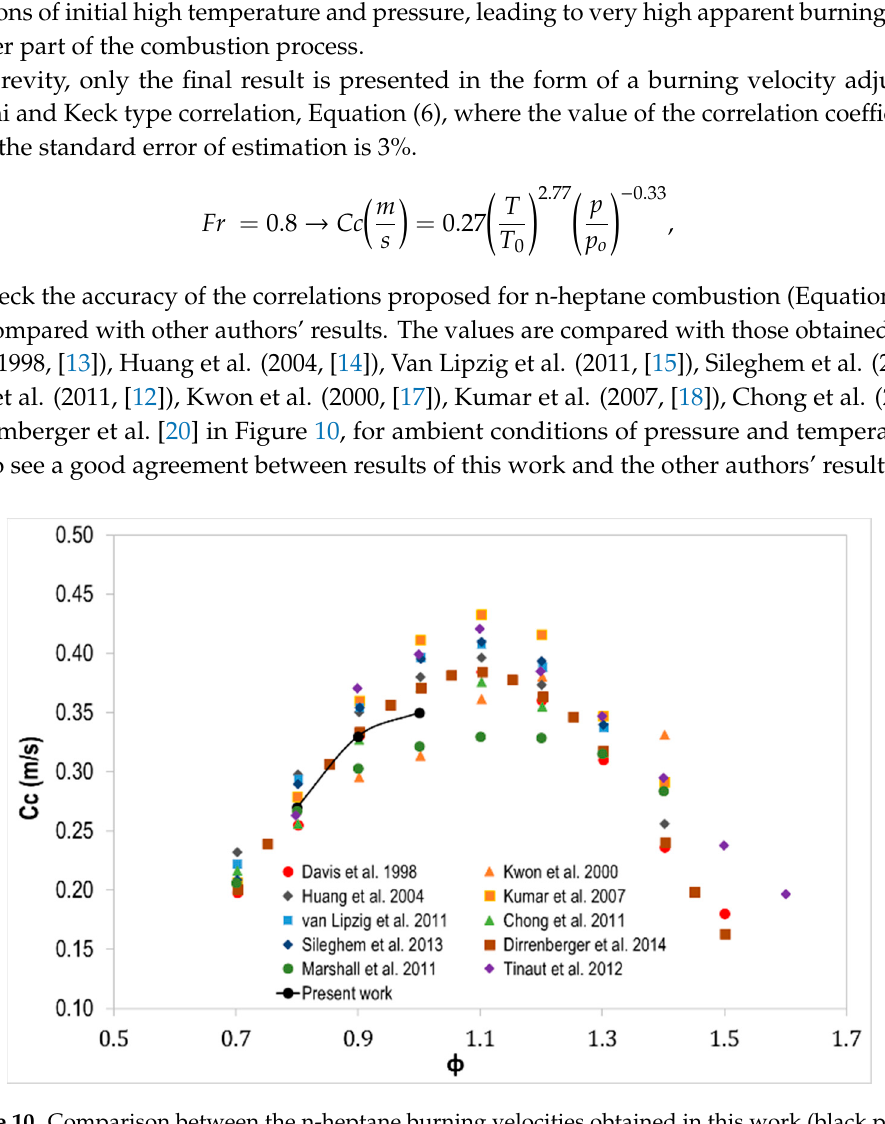
Figure 10. Comparison between the n-heptane burning velocities obtained in this work (black points) with the ones obtained by references [13].